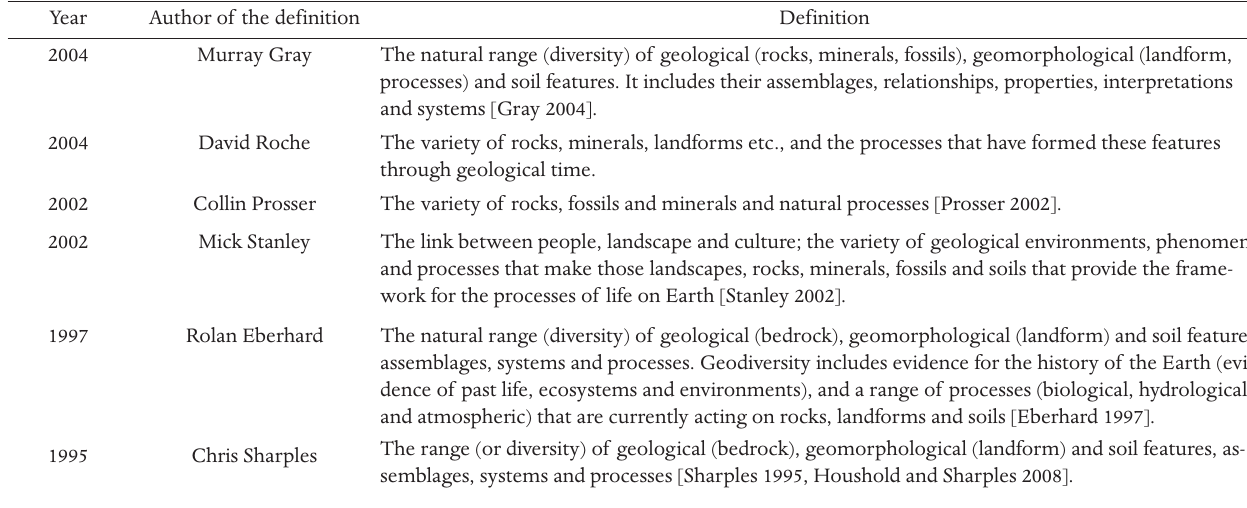
Table 1. Basic definitions of